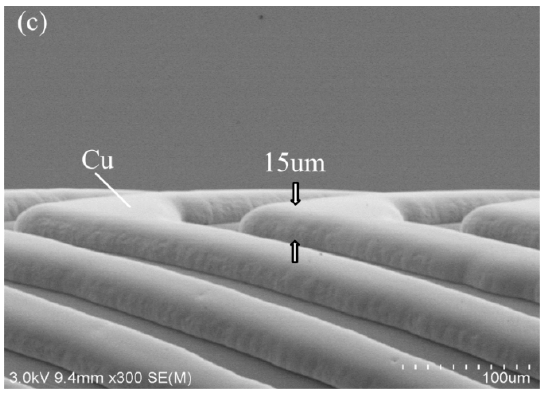
Figure 9. SEMs of the electroplated tilted microcoil. ( a ) Intact coil; ( b ) line width and spacing; ( c ) thickness of Cu microcoil.